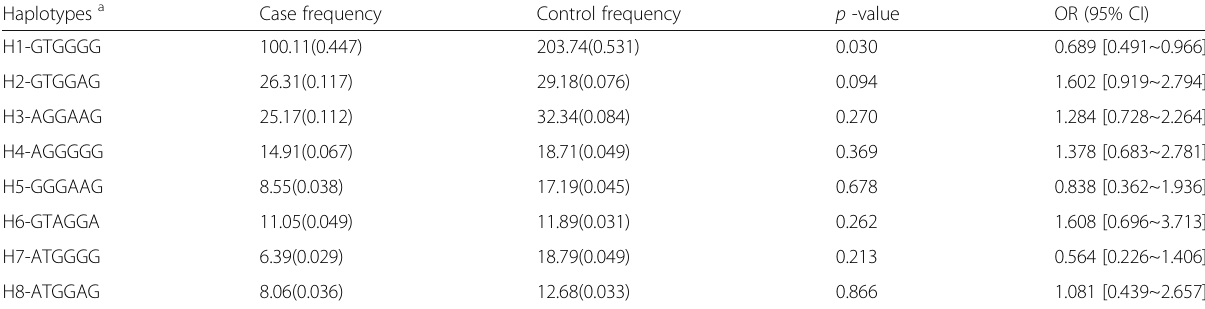
Table 3 Haplotype analysis of the HCRTR 2 SNPs between cases and controls Haplotypes